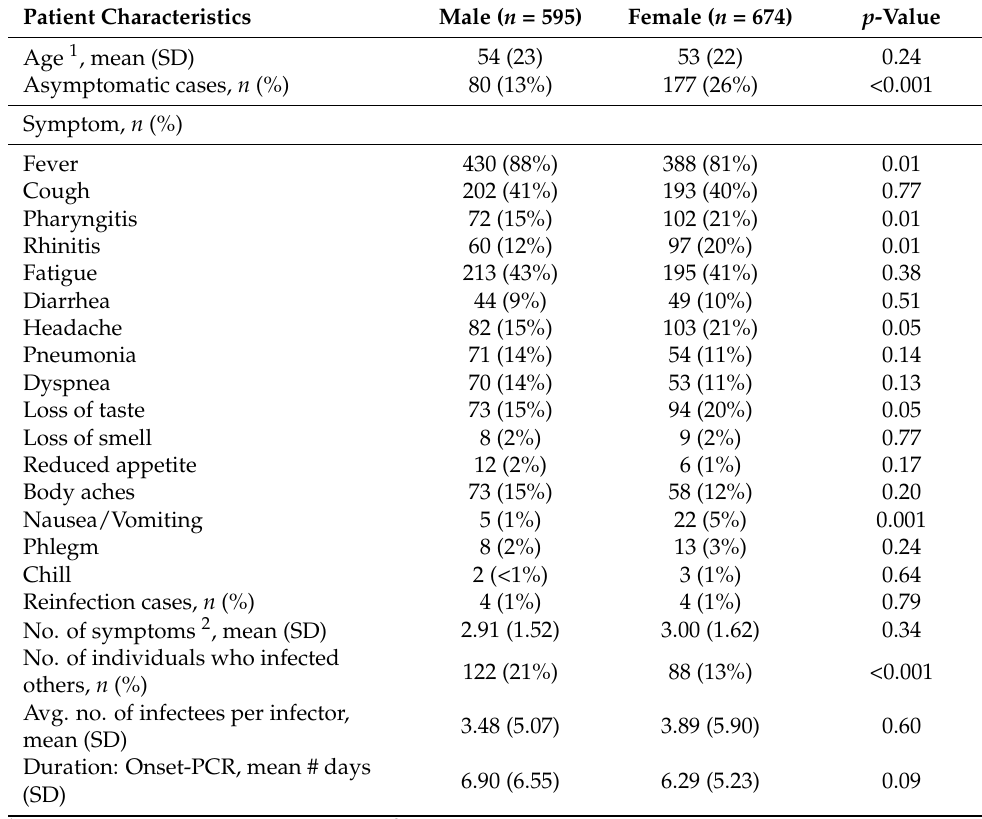
Table 1. Demographic and clinical characteristics of the